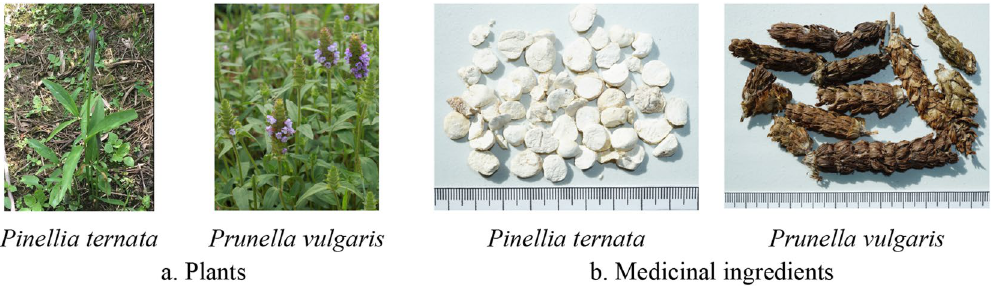
Figure 1. Photographs of Pinellia ternata ( Pinellia ternata (Thunb.) Breit.) and Prunella vulgaris ( Prunella vulgaris L.) in plant and medicinal ingredient